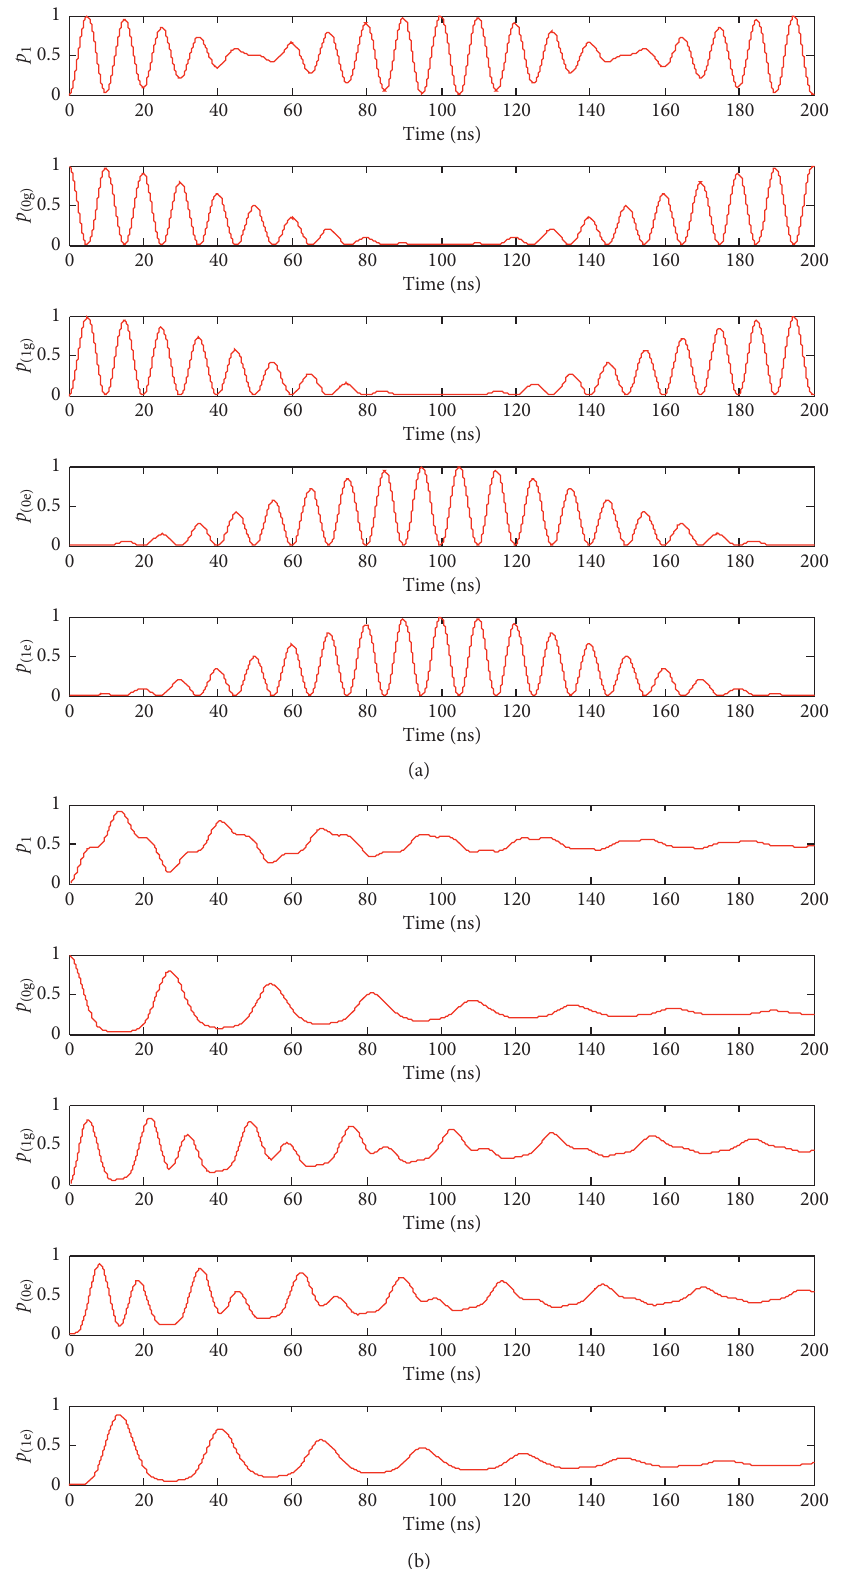
Figure 2: (a) From top to down. The occupation probability of superconducting qubit in the state | 1 〉 , | 0 g 〉 , | 1 g 〉 , | 0 e 〉 , and | 1 e 〉 without decoherence. (b) From top to down. The occupation probability of superconducting qubit in the state | 1 〉 , | 0 g 〉 , | 1 g 〉 , | 0 e 〉 , and | 1 e 〉 with decoherence. The coupling strength of qubit-TLS is η qT / Z ω � 0 . 005, and the coupling strength of qubit-microwave is η frequency of the microwave field is ω /2 π �